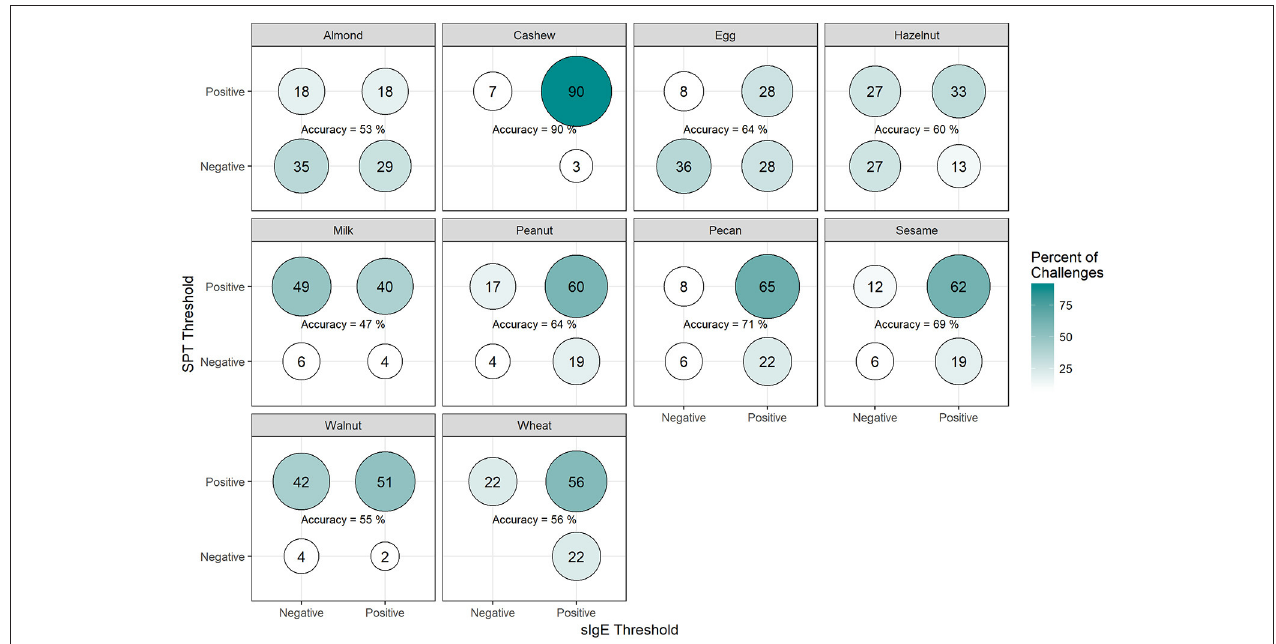
FIGURE 7 | Concordance of skin prick test (SPT) and allergen-specific IgE (sIgE) CTD-dependent thresholds in positive challenges. Among participants with positive challenges, the percentage of participants with each combination of SPT and sIgE values above or below the CTD-dependent ROC thresholds by food. Percentages in each food add up to 100%. Accuracy is the percentage of SPT positive and sIgE positive plus the percentage of SPT negative and sIgE negative.